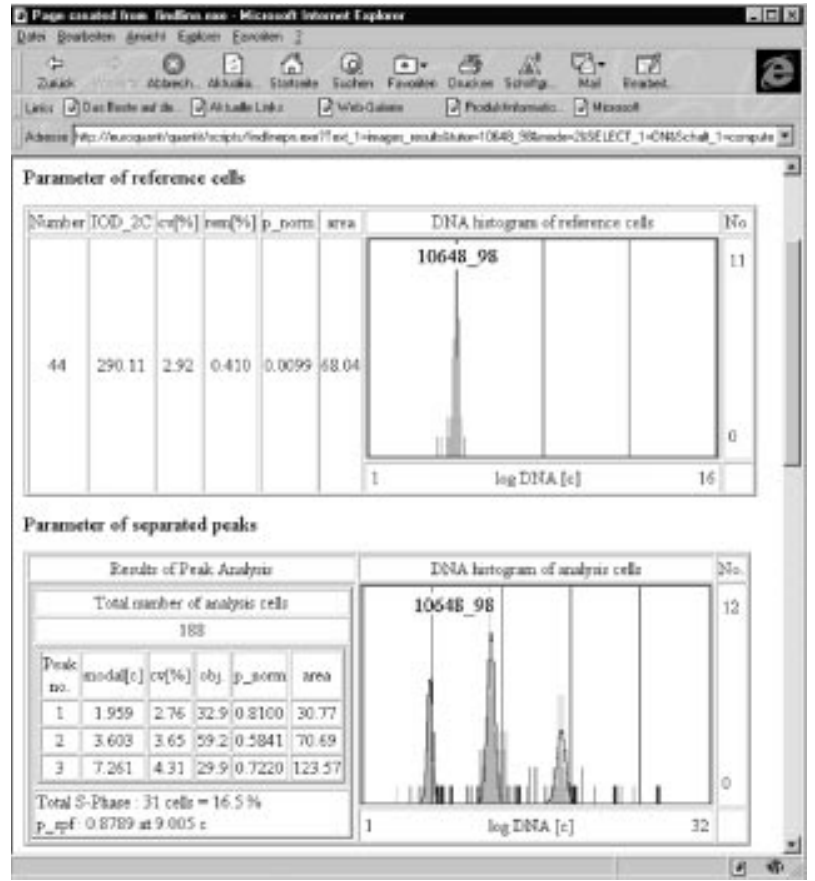
Fig. 3. A web page with results of a EUROQUANT DNA cytometric